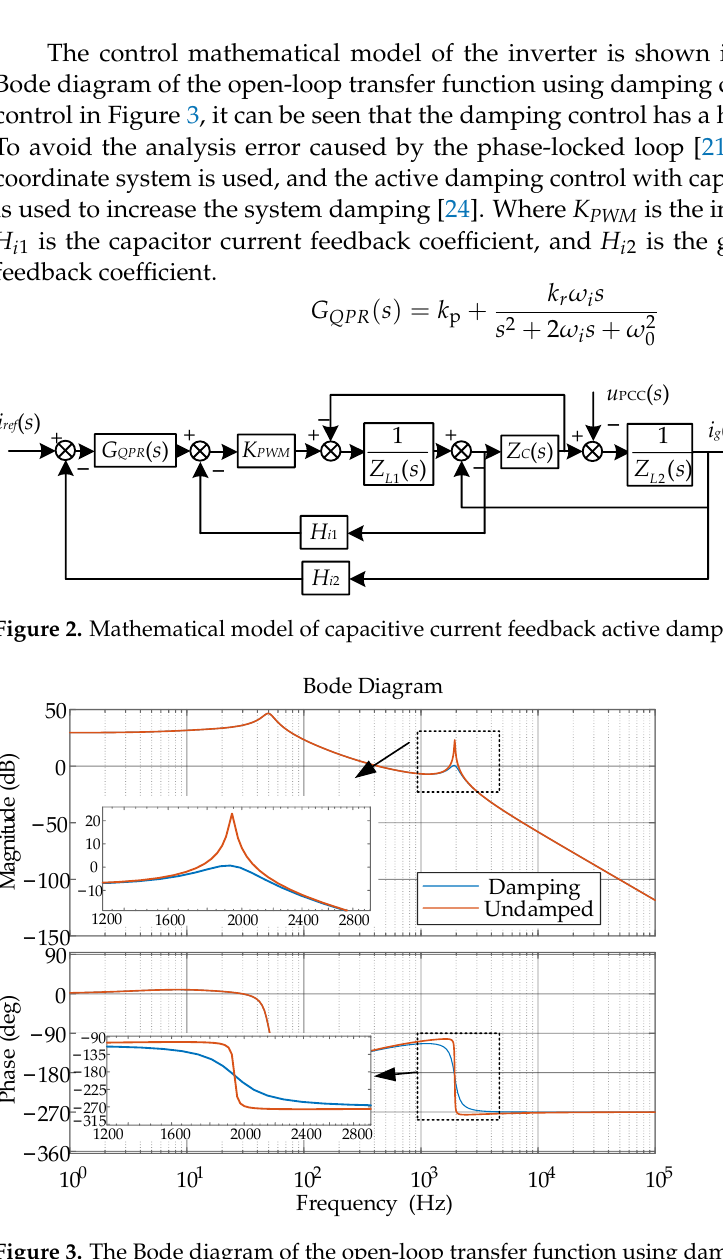
Figure 3. The Bode diagram of the open-loop transfer function using damping control and conven- tional undamped control.